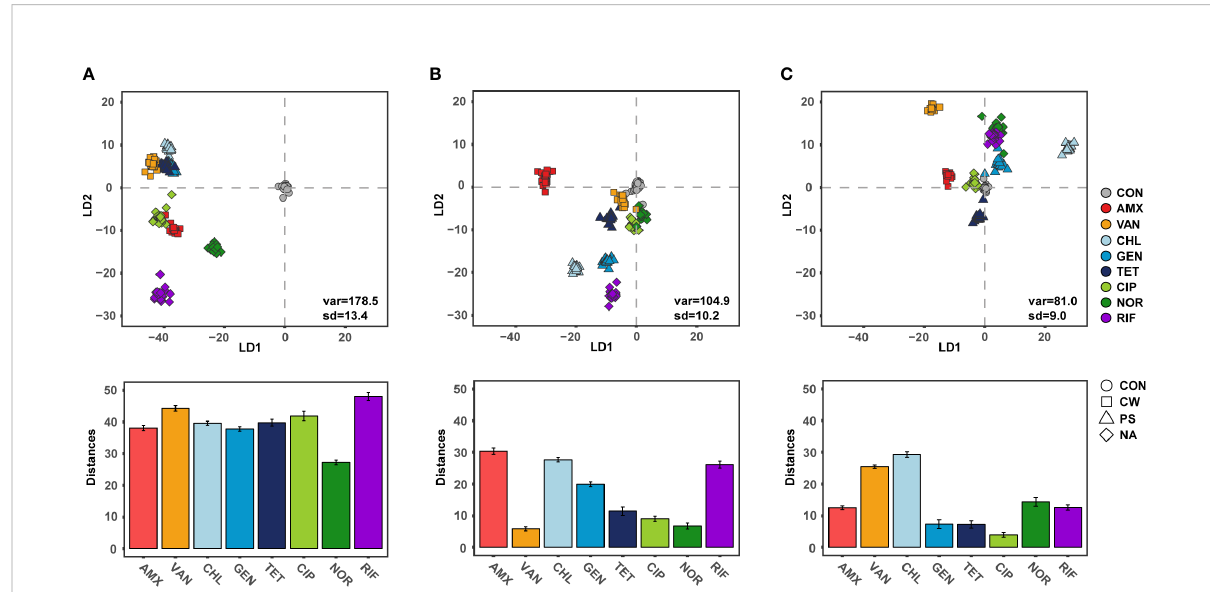
FIGURE 3 Discriminant of S.aureus according to the antibiotic treatments and Distance from centroids of control group to centroids of each groups. (A) 6 h treatment, (B) 12 h treatment, (C) 24 h